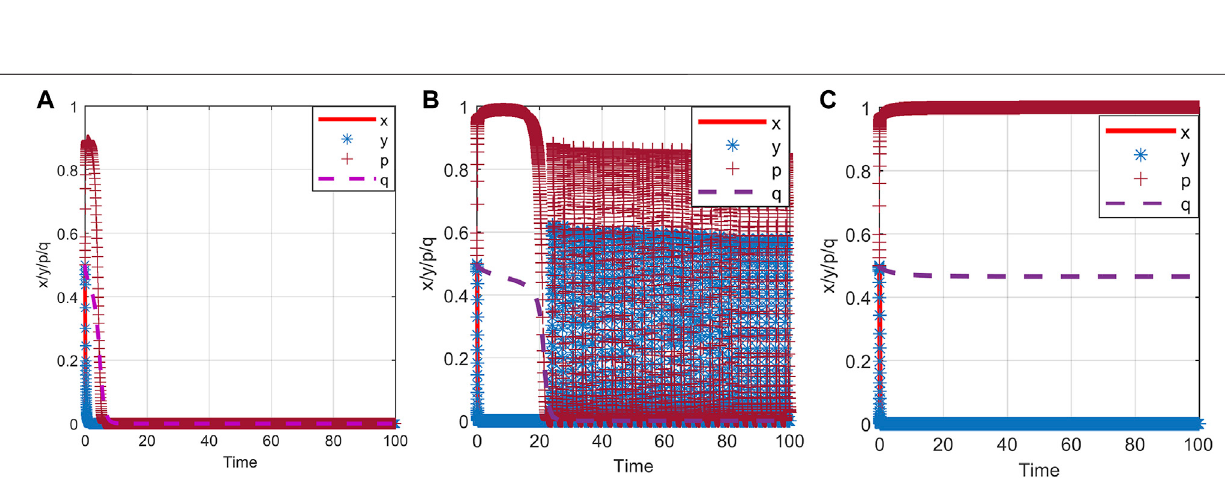
Frontiers in Environmental Science |